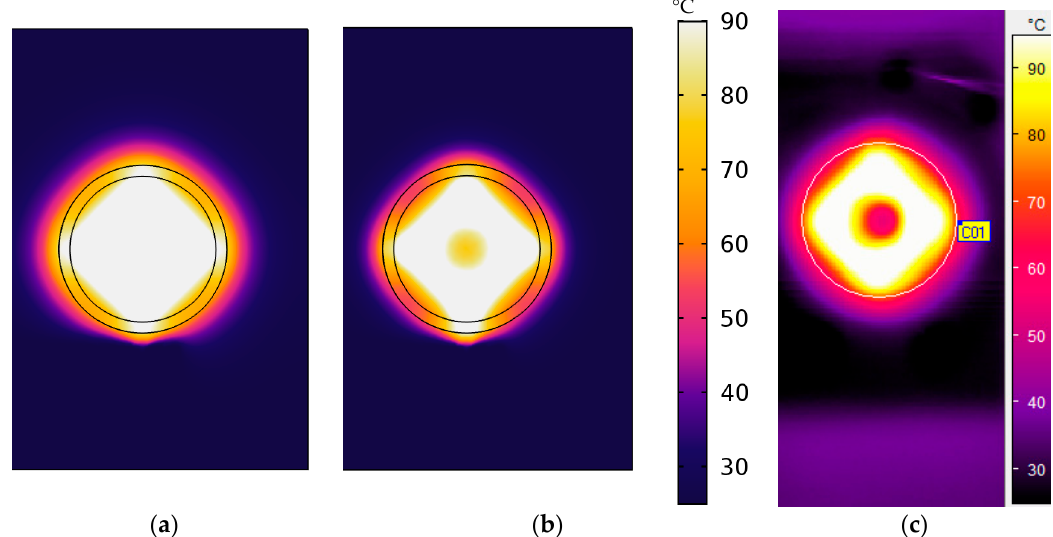
Figure 6. Temperature field on the membrane for 90 °C average temperature ( a ) and ( b ) from simulation with convection heat loss coefficient of 100 W/m 2 K and 217 W/m 2 K respectively ( c ) real measurement with IR camera for the thermoelectric sensor; ( a ) is more homogeneous than ( b , c ) where the small low-temperature circle may be caused by high convection heat loss.